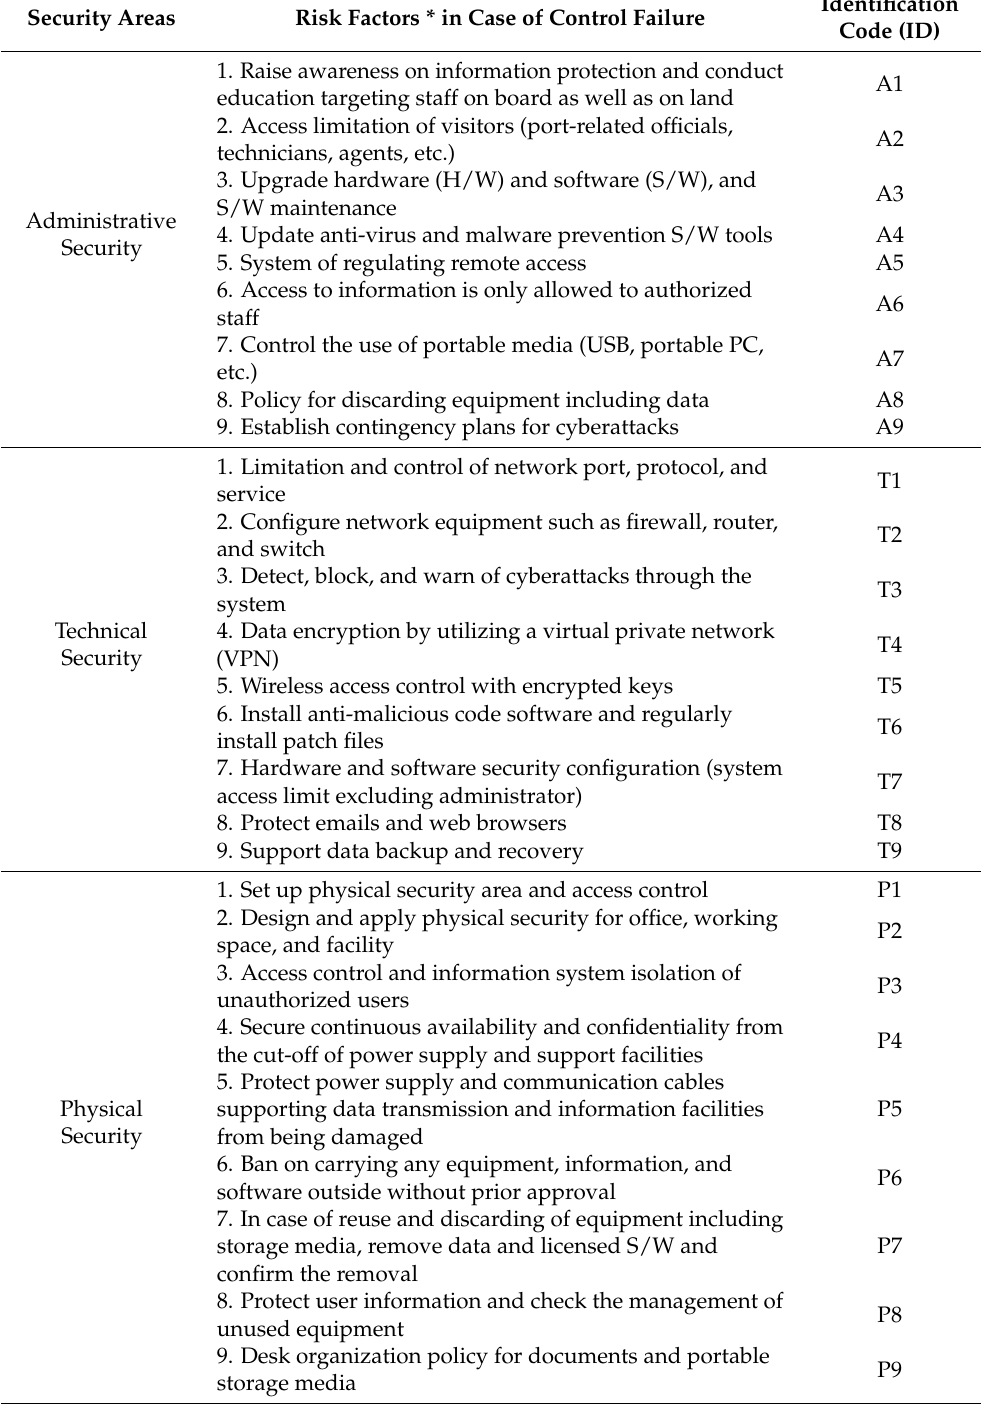
Table 1. Risk factors and identification codes by cybersecurity